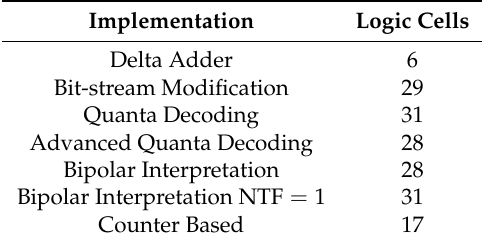
Table 5. Resource consumption of the implementations for addition on a